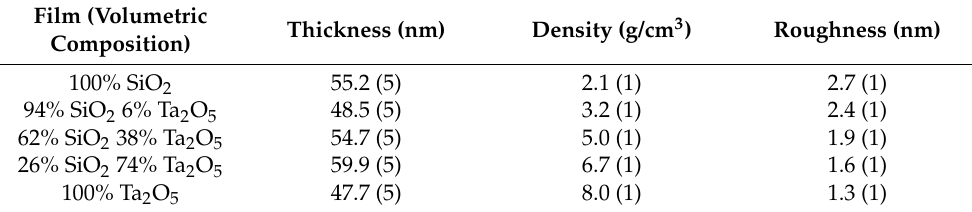
Table 2. Best fit parameter values refer to XRR curves shown in Figure 6.